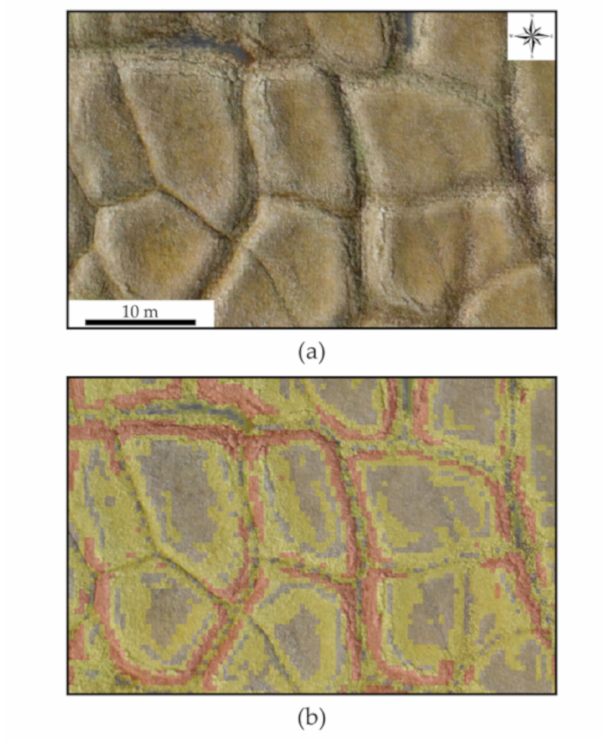
Figure 6. High-centered polygons (HCP) in ( a ) an orthophoto map that is mixed with a GSR map, and in ( b ) a slope map that overlays an orthophoto map. Yellow color is used for slopes with inclination from 3 ◦ to 10 ◦ , and red color marks slopes with an inclination of more than 10 ◦ . These maps show flat centers of HCP, which are higher than slightly elevated rims and